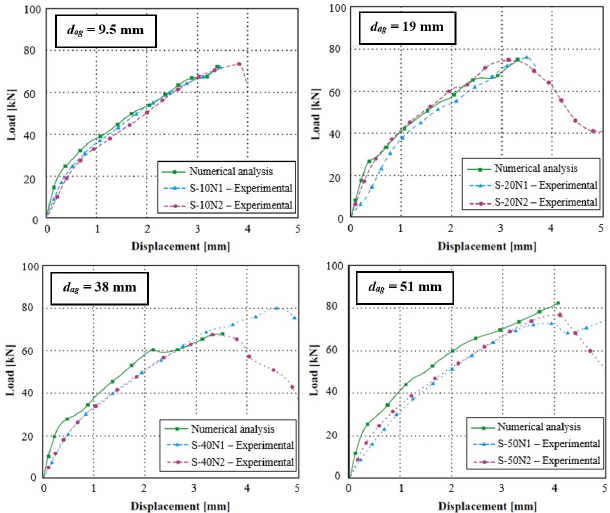
Figure 4. Load versus displacement curves for S-Series